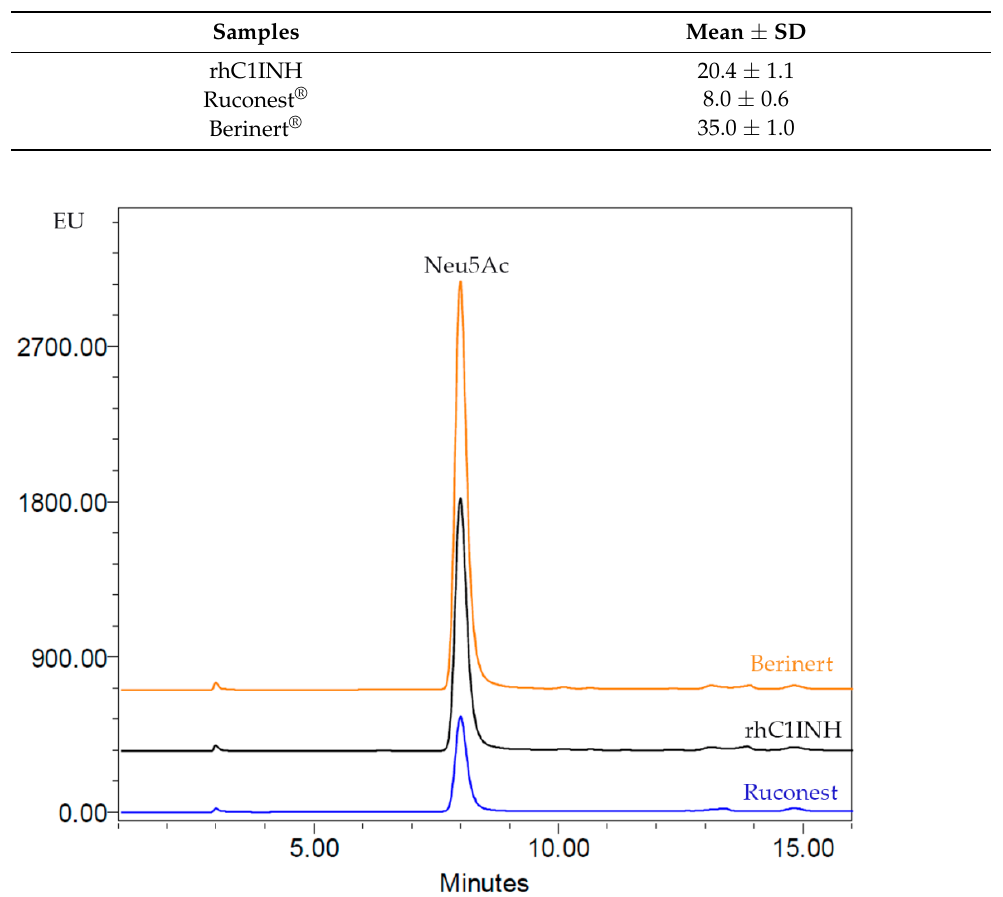
Table 7. The specific/biological activity of C1INH toward C1s subunit.